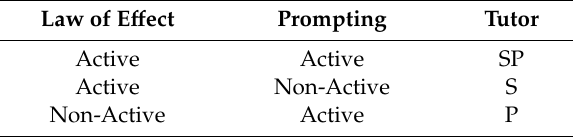
Table 1. ABA modules and resulting